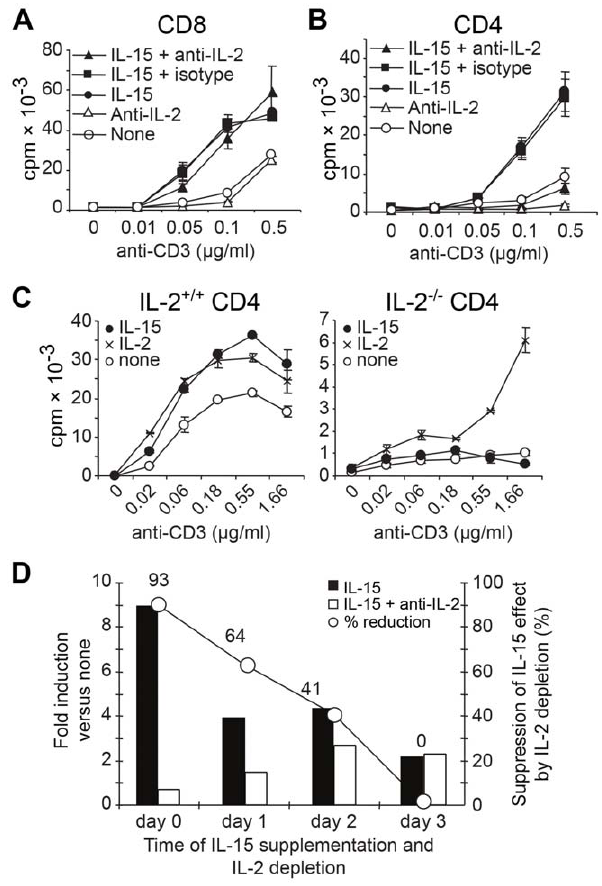
Figure 2. IL-15 growth factor activity depends on TCR-signals, but is IL-2-dependent only in CD4 + T cells. ( A ) CD8 + or ( B ) CD4 + T cells were stimulated with anti-CD3 mAb and irradiated TdACs in the absence or presence of 3 ng/ml rhIL-15, or 10 m g/ml anti-IL-2 mAb (JES6-5H4) or isotype control, as indicated. On day 4, 3 H-thymidine incorporation was measured. Results are from one of five experiments. ( C ) IL-2 + / + or IL-2 2 / 2 CD4 + cells were stimulated with anti-CD3 mAb and irradiated IL-2 + / + and IL-2 2 / 2 splenocytes, respectively, in the absence (white circles) or presence of 1 ng/ml IL-2 (crosses) or 3 ng/ml IL-15 (black circles). ( D ) CD4 + cells were stimulated for 5 days with 0.1 m g/ml anti-CD3 and irradiated TdACs. On day 0, 1, 2, or 3, IL-15 alone or IL-15 plus anti-IL-2 mAb was added. On day 4, proliferation was measured by 3 H-thymidine incorporation and represented as bar graphs (with left Y- axis) as ratio of cpm IL-15 /cpm none (black bars) or cpm IL-15 plus anti-IL-2 / cpm none (white bars). The line represents the percentage of reduction of the IL-15 effect by IL-2 depletion as calculated using the following formula: [(cpm IL-15 – cpm IL-15 plus anti-IL-2 )/cpm IL-15 ] 6 100. Results are from one representative out of three experiments.